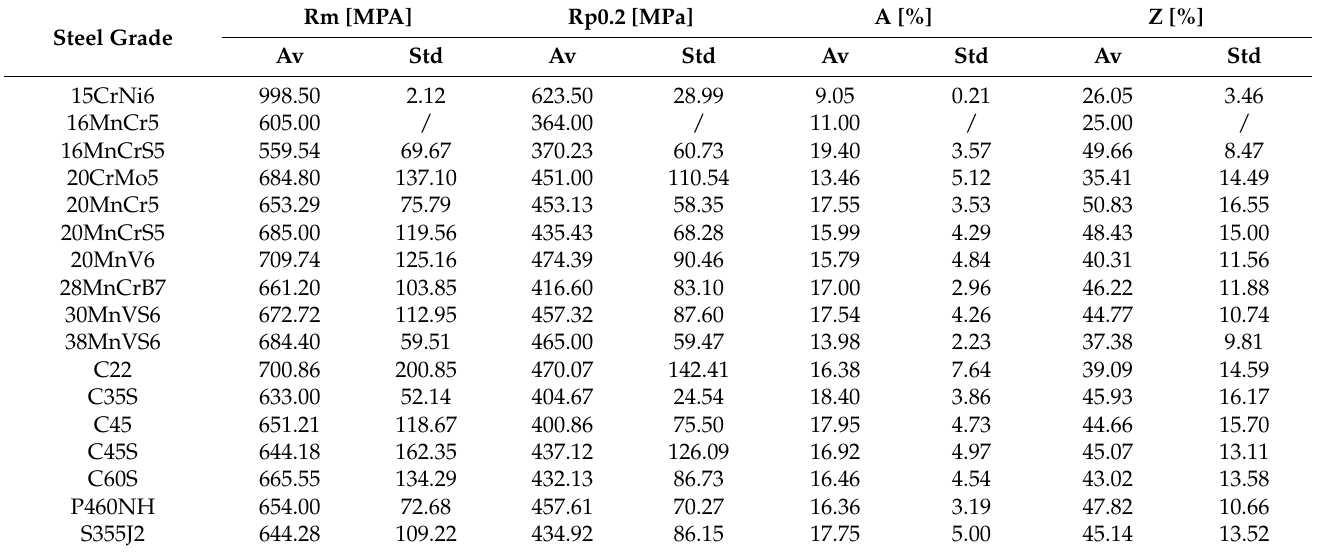
Table 2. The tensile, yield strength, percentage elongation and reduction area (average and stan- dard